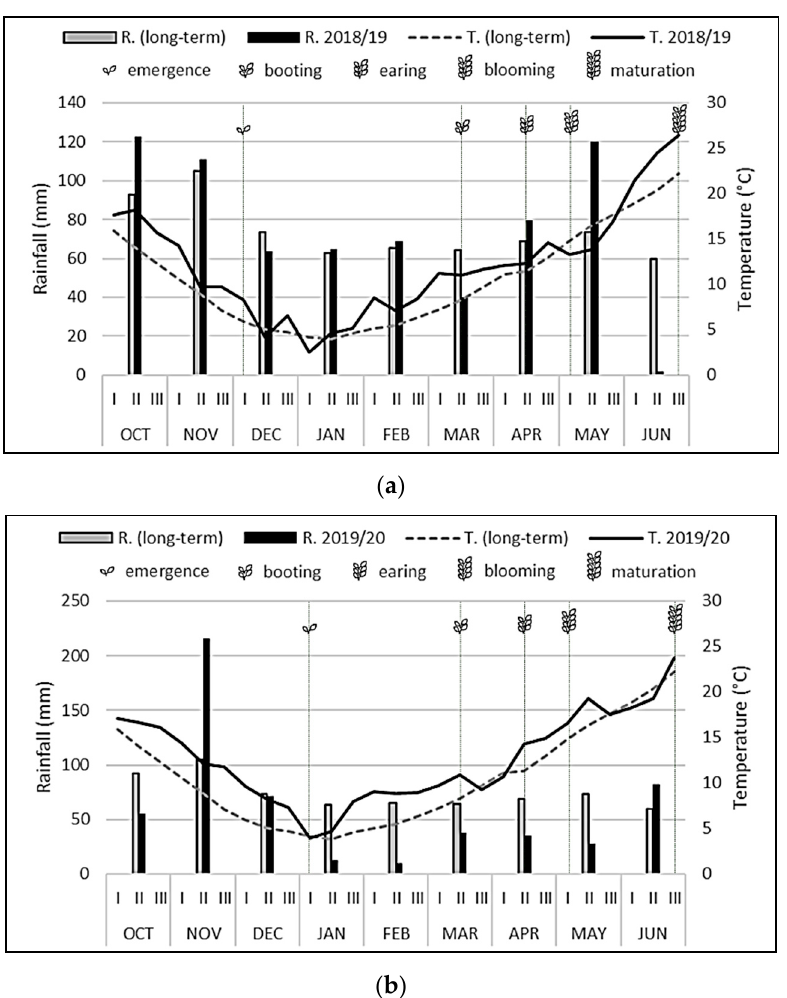
Figure 2. Monthly cumulated rainfall and average temperatures per decade during the wheat growing seasons ( a ) 2018–2019 and ( b ) 2019–2020 compared to the long ‐ term mean values (temperature 1951–2018, rainfall 1921–2018).